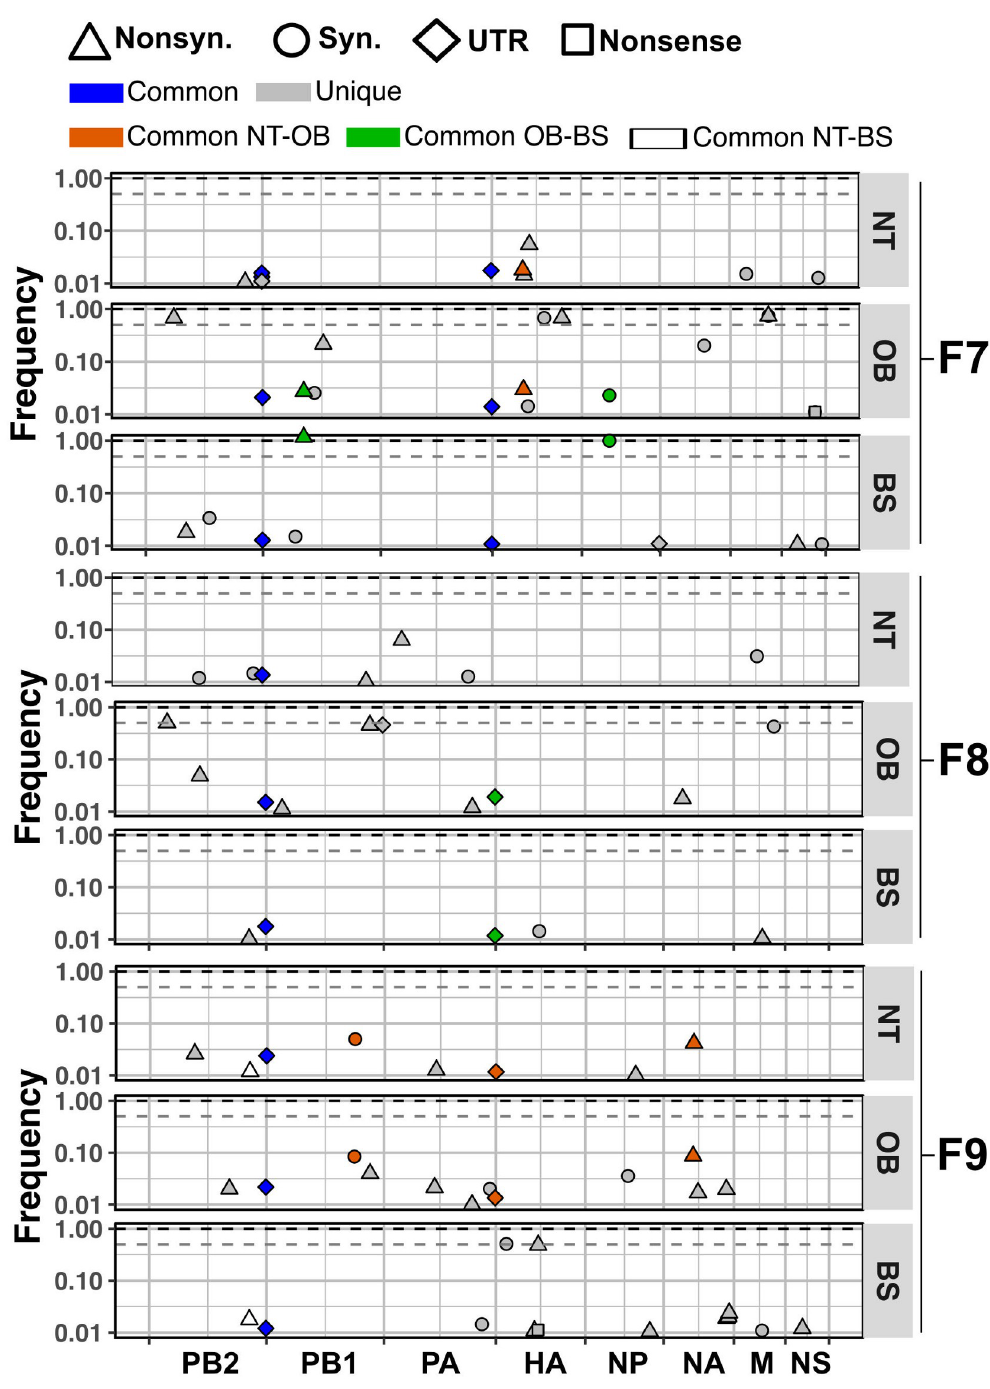
Fig 6. Dispersion of H5N1-WT virus variants from nasal turbinates to the CNS. Unique variants are presented in grey. Common variants between nasal turbinate (NT) and olfactory bulb (OB) are in orange. Common variants between the olfactory bulb and the brainstem (BS) are in green. Common variants between nasal turbinate and brainstem are in white. Variants that are common throughout are in blue. The types of mutation are represented by shapes: synonymous (Syn.) as circles, nonsynonymous (Nonsyn.) as tringles, variants in the untranslated regions (UTR) as diamonds and nonsense as squares. Nucleotide position within the concatenated viral genome is shown on the x-axis. Dashed grey line shows consensus cut off at frequency of 0.5 whereas the dashed black line marks a frequency of 1.